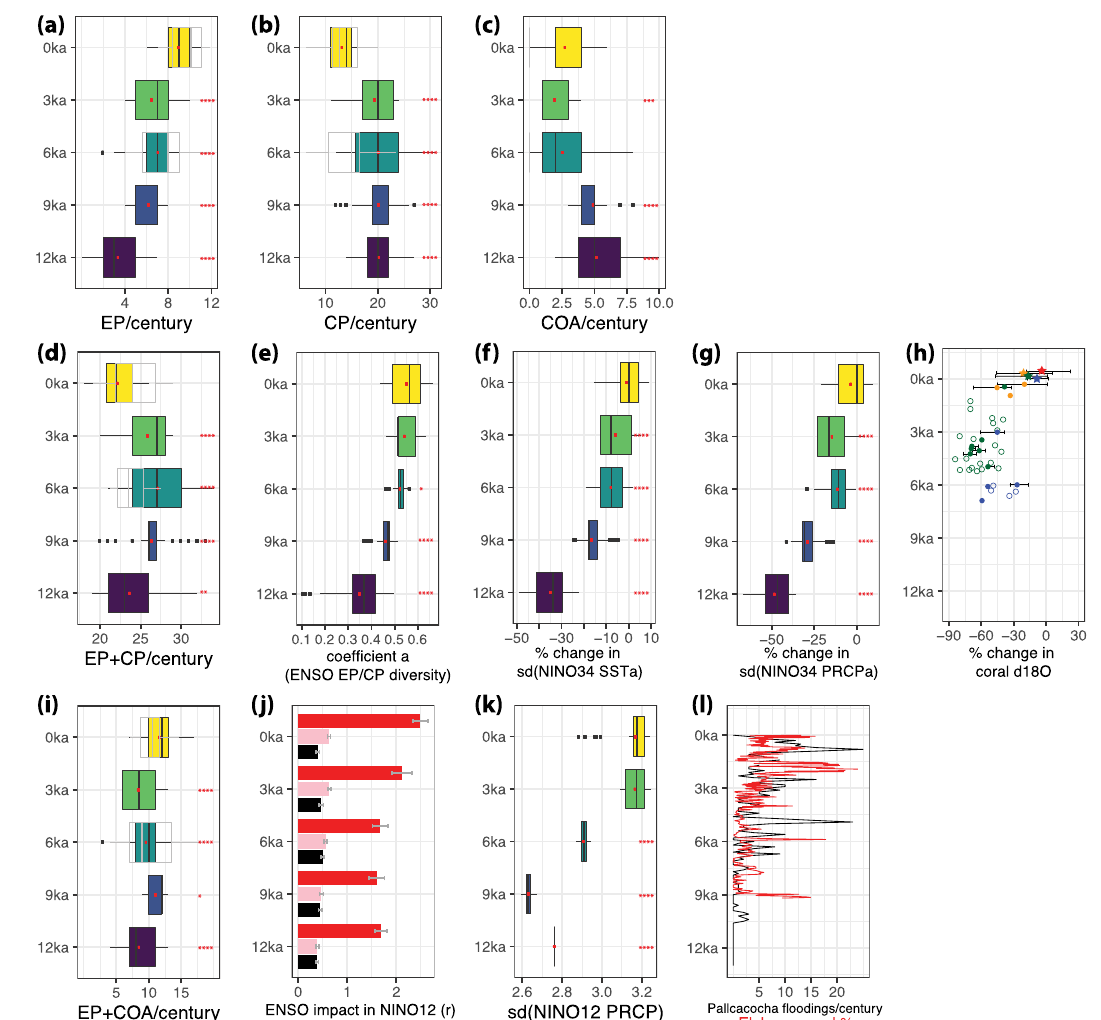
Fig.2| SimulatedchangesinElNiño-SouthernOscillation(ENSO) fl avorsinthe Holocene (top), and simulated and proxy changes in central Paci fi c (middle) and far eastern Paci fi c (bottom) hydroclimate. The toppanel shows the number of a Eastern Paci fi c (EP), b Central Paci fi c (CP), and c Coastal (COA) events per century in the Holocene time-slice experiments with the Community Earth System Model v1 (CESM1). The middle panel shows d the number of “ central Paci fi c in fl u- ence ” (EP+CP)eventspercentury, e thecoef fi cient α ,whichisametricofENSOEP/ CP diversity, the simulated changes in sea surface temperature (SST) ( f ) and pre- cipitation ( g ) variability in the NINO3.4 region, and h the change in 1.5 – 10 yr standarddeviationofcoral δ 18 O fromthecentralPaci fi c(Kiritimati-green 6 ;Fanning- blue 5 ;Palmyra-orange 26 ) relative to the 1977 – 2007 reference period. In sub fi gure h , which is adapted from Karamperidou et al. 7 , stars indicate modern records (twentieth century), and circles show fossil coral records with open circles indi- cating records<30yr and errorbarsshowing the range of30yr variability incoral records>30 yrs. The bottom panel shows i the number of simulated “ eastern